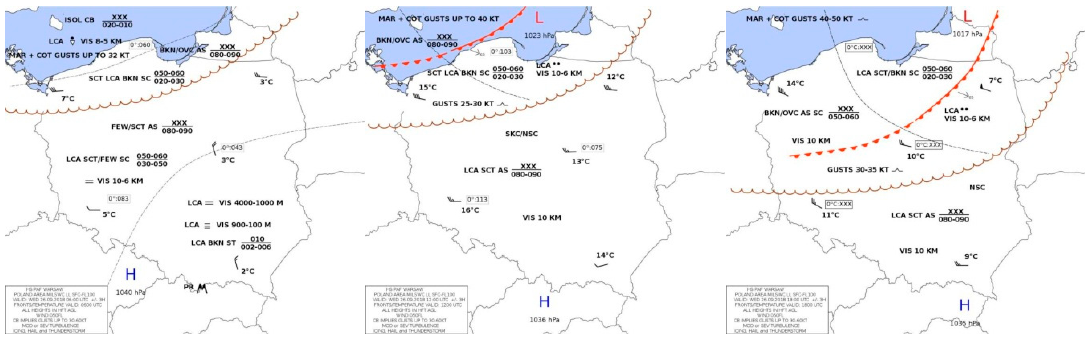
Remote Sens. 2019 , 10 , x FOR PEER REVIEW 11 of 25 over 10 km (Figure 10). The maximum temperature was 11–13°C. The 0°C isotherm was located at Figure 9. Europe synoptic map September 26, 2018, at 12:00 UTC (based on Reference [42]). 3000–3400 m.